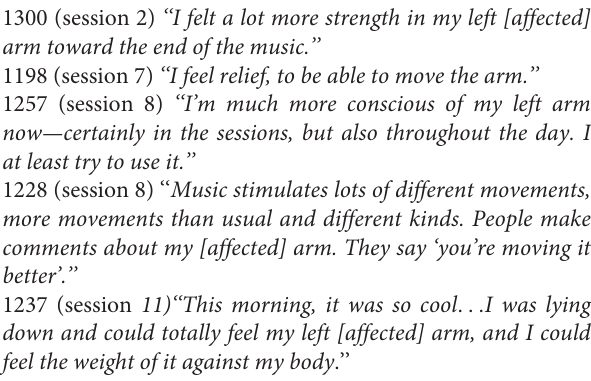
Frontiers in Human Neuroscience |